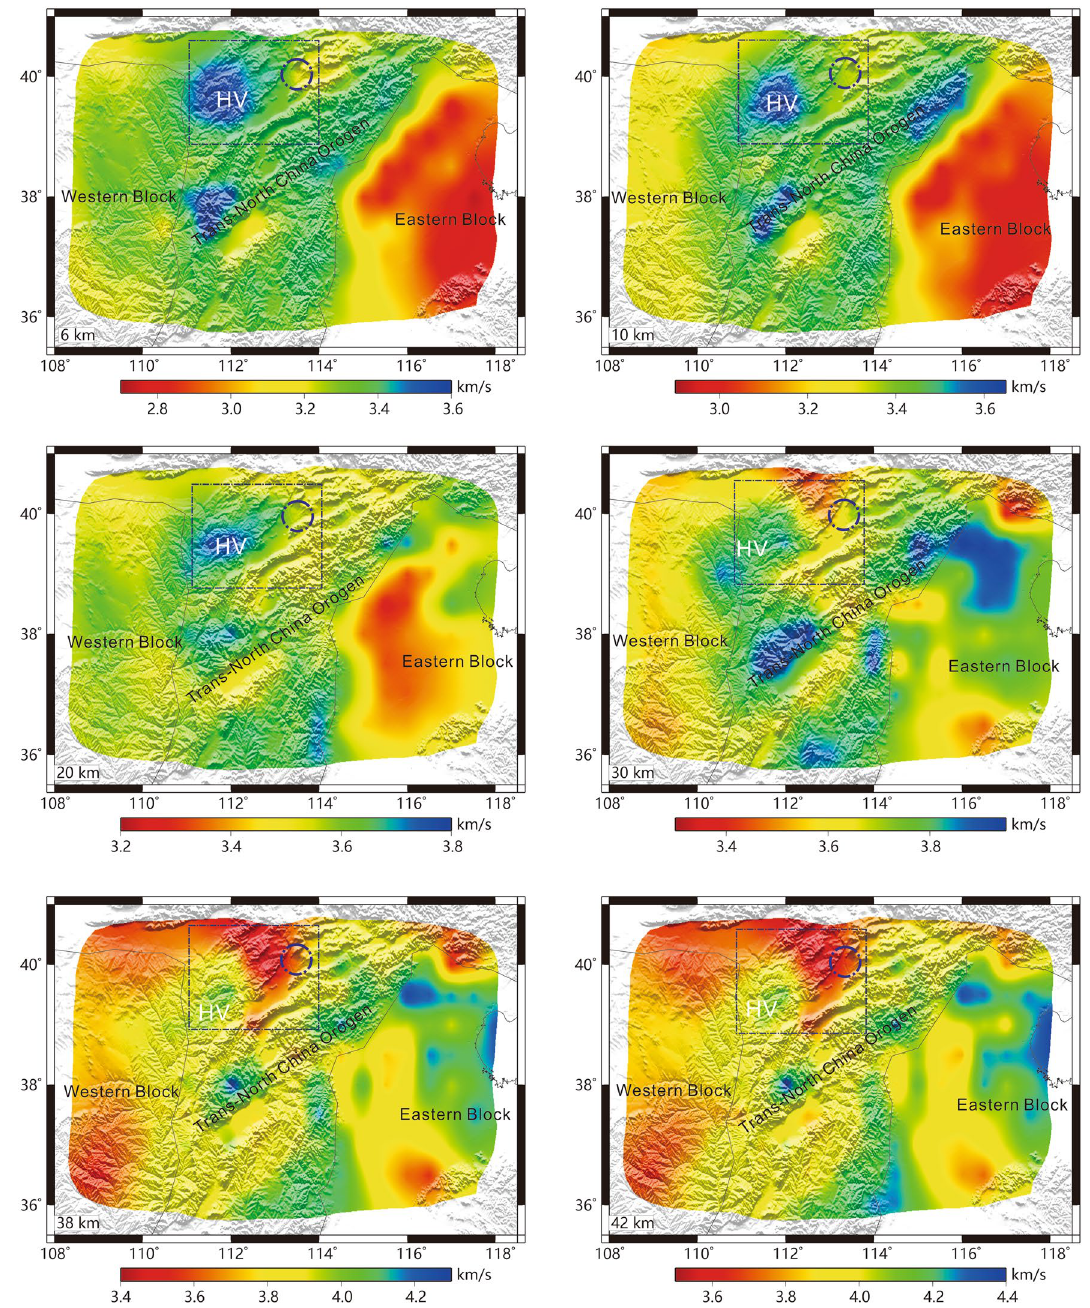
Figure 4. S-wave velocity distributions at depths of 6 km, 10 km, 20 km, 30 km, 38 km and 42 km. Blue circle: Datong volcanic group. The black lines are the boundaries of geological units. Rectangle region: Cenozoic basalt region [the figure was generated by Chuansong He using Generic Mapping Tools (https:// www. gener ic- mappi ng- tools.